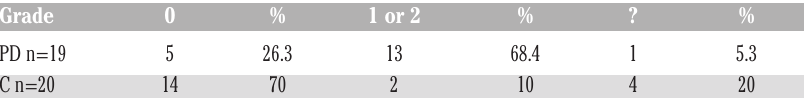
Table 2. Parkinson’s disease. data collated – parkinson’s disease patients and control